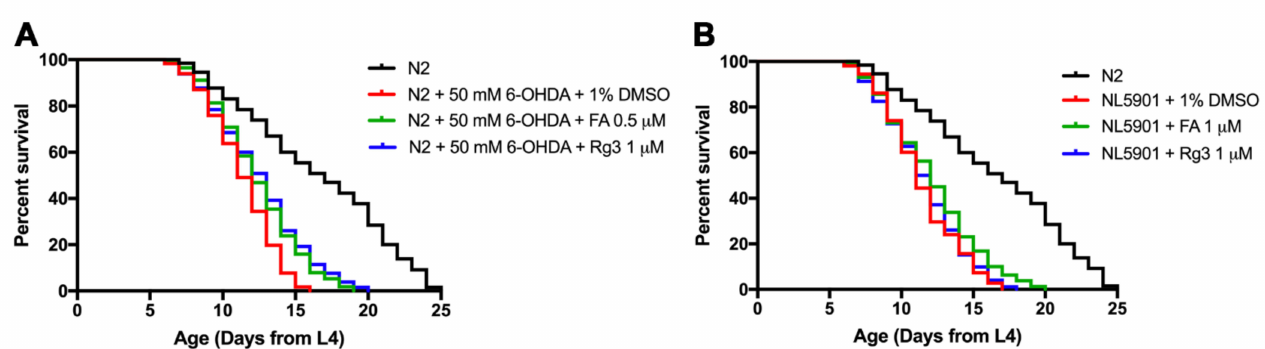
Figure 6. Effects of FA and Rg3 on lifespan of 6-OHDA-induced and transgenic α -synuclein NL5901 worms. ( A ) Survival curves of wild-type N2, 6-OHDA-induced, and FA/Rg3-treated worms. ( B ) Survival curves of wild-type N2, DMSO- cultured NL5901 and FA/Rg3-treated NL5901. The experiment was performed independently at least three times (number of worms = 30–40 animals/group per